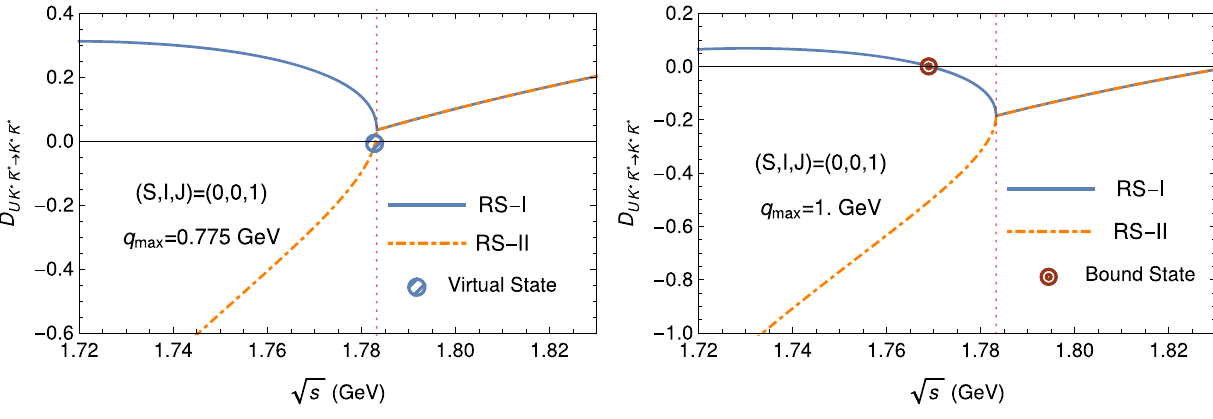
Fig. 6 The real part of the D U function for K ∗ ¯ K ∗ → K ∗ ¯ K ∗ with ( S , I , J ) = ( 0 , 0 , 1 ) on the real axis on the first (solid line) and second Riemann sheet (dashed line) with the cutoff q max = 0 . 775 GeV and 1.0 GeV,